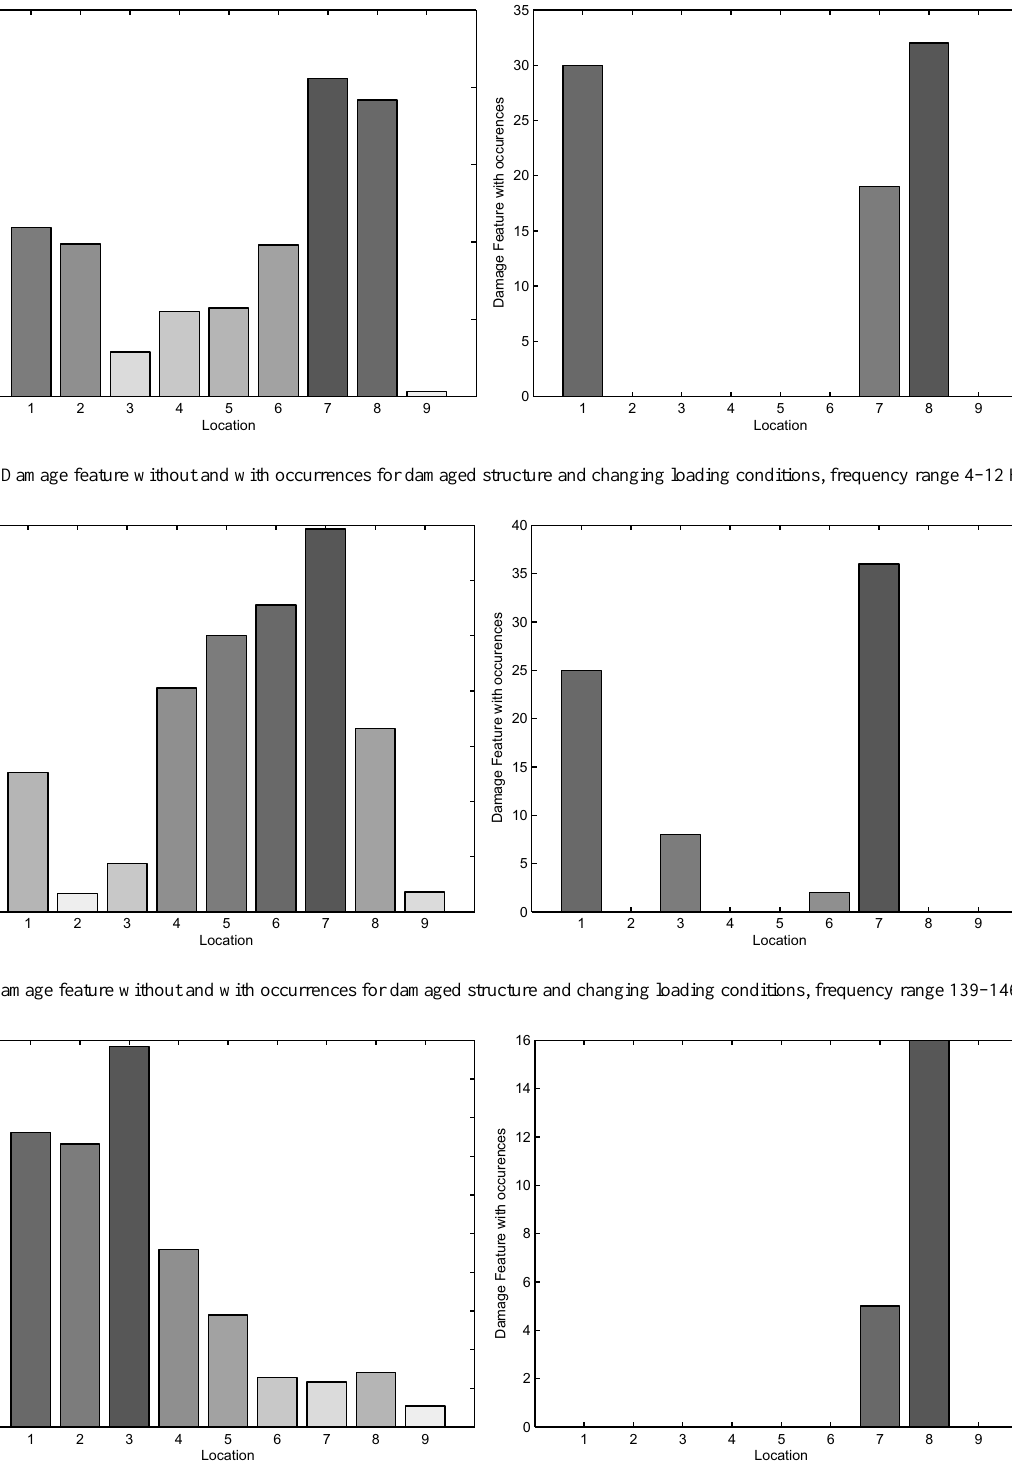
Fig. 24. Damage feature without and with occurrences for damaged structure and changing loading conditions, frequency range